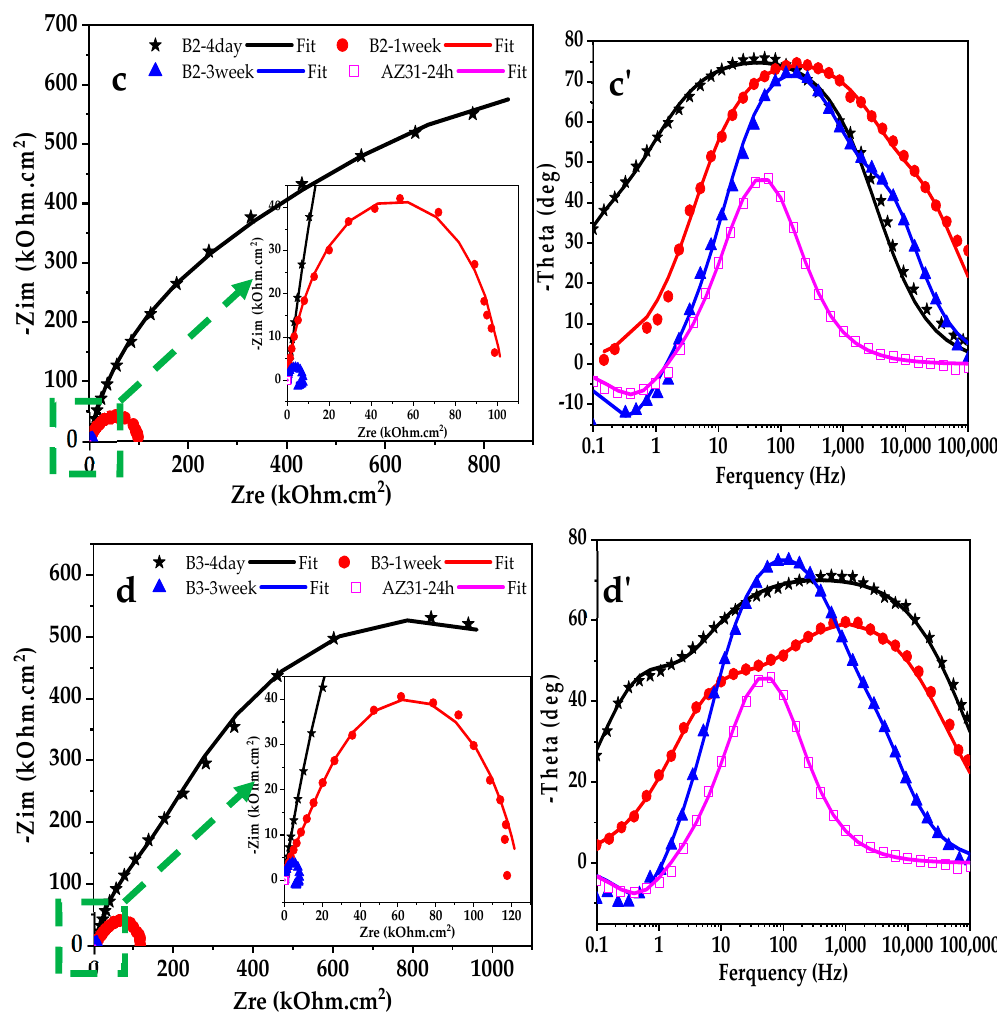
Figure 10. Nyquist plots and Bode-phase plots of the coated samples after long-term exposure to 3.5 wt. % NaCl solution for: ( a , a’ ) U, ( b , b’ ) B1, ( c , c’ ) B2 and ( d , d’ ) B3. Coatings 2019 , 9 , x FOR PEER REVIEW After 3 weeks, the Bode-phase plots show only one hump for the coating produced by the U waveform indicating that its outer porous layer is not responding anymore. However, other coatings still show two humps, which are more pronounced for the coating produced by B2 waveform than B1 and B3. Moreover, inductive loops appear after 3 weeks at the lowest frequencies for all coatings, which indicate that some uncoated areas caused by local attack of the substrate are in direct contact with the electrolyte [40]. The equivalent electrical circuits (ECs) used for fitting the impedance data are illustrated in Figure 11. R s is uncompensated solution resistance, R out and CPE out are resistance and constant phase element of the outer porous layer, respectively, R in and CPE in are resistance and constant phase element relating to the inner barrier layer, respectively. Inductor L and R L are also added to the ECs to describe the inductive behavior [28,40]. The fitting results are represented by the solid lines in Figure 10 . The best fitting parameters ( χ 2 < 0.003) are shown in Table 4. Figure 11. The electrical equivalent circuits used for fitting the EIS data; ( a ) after 4 days and 1-week exposure, ( b ) after 3 weeks of exposure for U and ( c ) after 3 weeks of exposure for B1, B2 and B3 waveforms. Table 4. Electrical elements values extracted for EIS diagrams using Zview software for U, B1, B2 and B3. Specimen